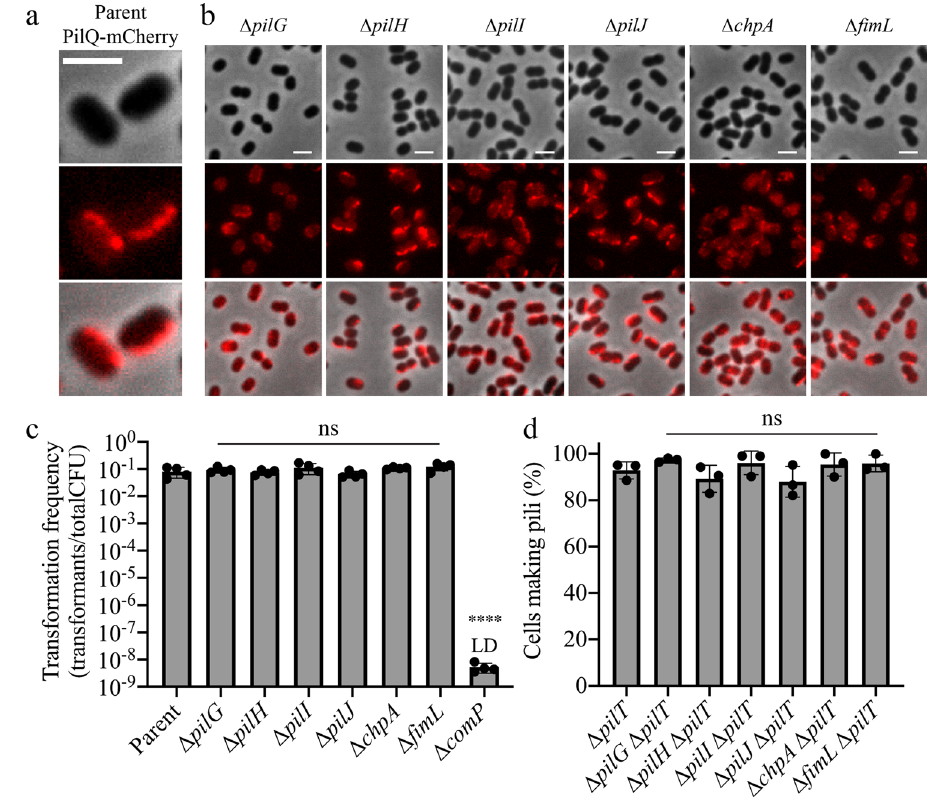
Fig.2|ThePil-Chppathwayin A.baylyi hasevolutionarilydivergedinfunction to control T4P localization. a Representative image of the parent strain con- taining a T4P machinery fl uorescent mCherry fusion to the outer membrane secretin protein, PilQ, with background fl uorescence subtracted. b Representative images of PilQ-mCherry localization in different Pil-Chp mutants with background fl uorescencesubtracted. c Naturaltransformation assays of indicated strains. Each data point represents a biologicalreplicate and bar graphs indicate the mean±SD. Thetransformationfrequencyofthe Δ comP strainwasbelowthelimitofdetection, indicatedby LD. d Quanti fi cation of the percentage of cells in apopulation making